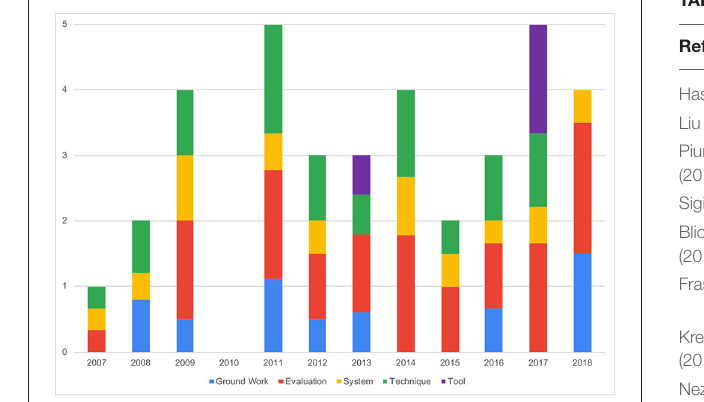
FIGURE 4 | An overview of the different paper types per year. The full bars depict the number of papers per year. Different colors of the segments within the bars give an impression about the paper types within the papers. Please note that several categories may apply to a single paper, for instance, the single paper in 2007 is associated with three